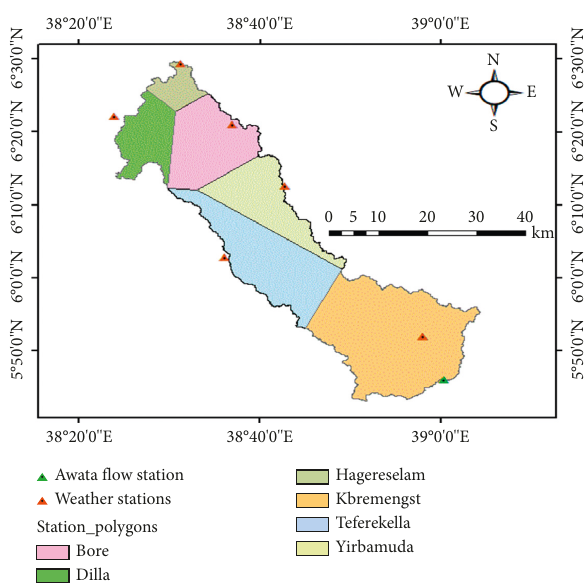
Figure 7: Location of gauging stations and Thiessen polygons for weather stations.